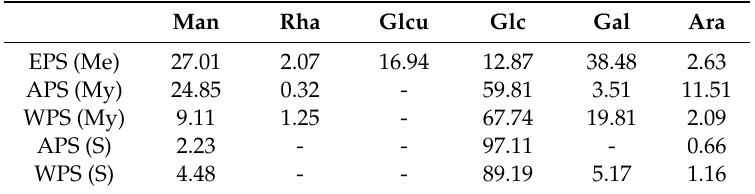
Table 1. Monosaccharide content (%) of each class of polysaccharide.